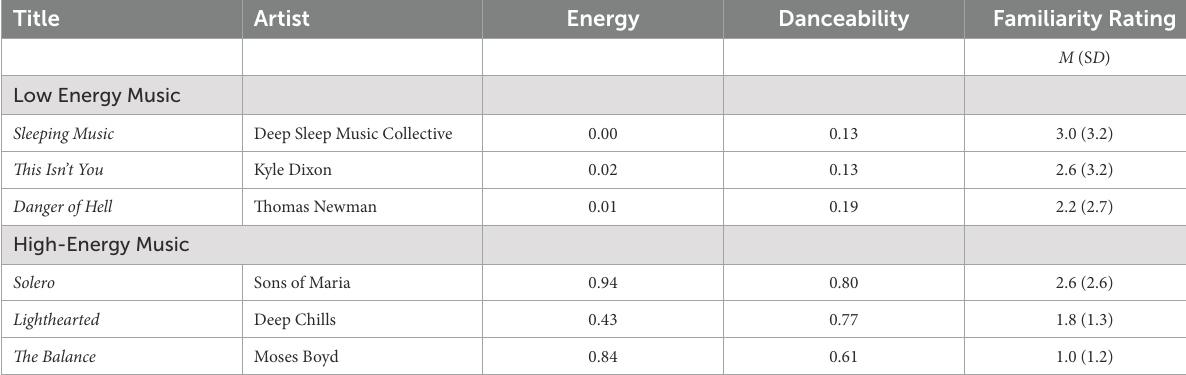
TABLE 2 Music Stimuli and Familiarity Ratings from Pilot